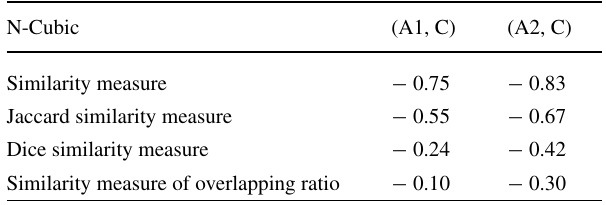
Table 2 Comparison Analysis between the existing and our proposed method N-Cubic (A1, C) (A2, C) Similarity measure − 0.75 − 0.83 Jaccard similarity measure − 0.55 − 0.67 Dice similarity measure − 0.24 − 0.42 Similarity measure of overlapping ratio − 0.10 −